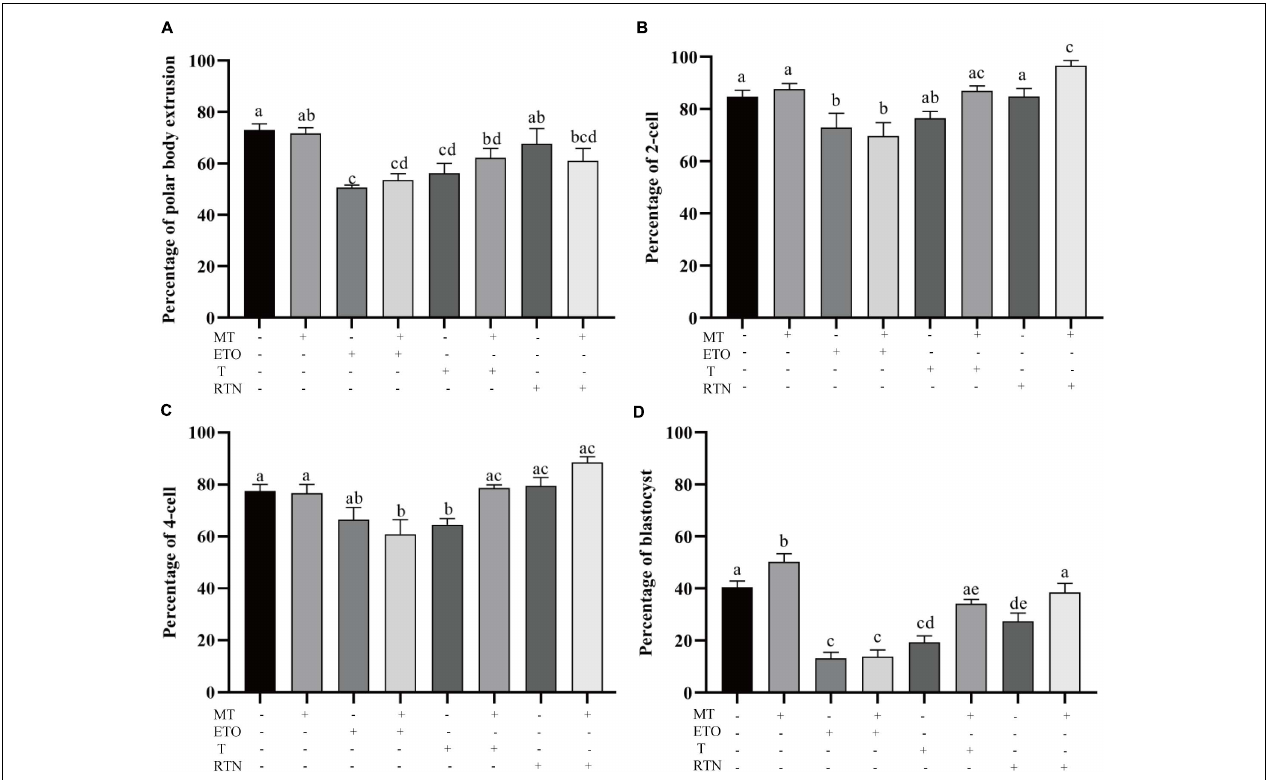
FIGURE 3 | Lipid metabolism regulates the developmental competence of porcine oocytes. (A) The percentage of polar body extrusion in porcine oocytes treated with control ( n = 2,386), melatonin ( n = 894), etomoxir ( n = 1,303), etomoxir + melatonin ( n = 1,301), triacsin C ( n = 931), triacsin C + melatonin ( n = 1,026), rotenone ( n = 710), and rotenone + melatonin ( n = 706). (B) The percentage of two-cell embryos in porcine oocytes treated with control ( n = 899), melatonin ( n = 445), etomoxir ( n = 739), etomoxir + melatonin ( n = 654), triacsin C ( n = 207), triacsin C + melatonin ( n = 315), rotenone ( n = 414), and rotenone + melatonin ( n = 328). (C) The percentage of four-cell embryos in porcine oocytes treated with control ( n = 899), melatonin ( n = 445), etomoxir ( n = 739), etomoxir + melatonin ( n = 654), triacsin C ( n = 207), triacsin C + melatonin ( n = 315), rotenone ( n = 414), and rotenone + melatonin ( n = 328). (D) The percentage of blastocysts in porcine oocytes treated with control ( n = 899), melatonin ( n = 445), etomoxir ( n = 739), etomoxir + melatonin ( n = 654), triacsin C ( n = 207), triacsin C + melatonin ( n = 315), rotenone ( n = 414), and rotenone + melatonin ( n = 328). Student’s t -test and one-way ANOVA were utilized for statistical analyses. Different lowercase letters indicate significant differences. Error bars indicate